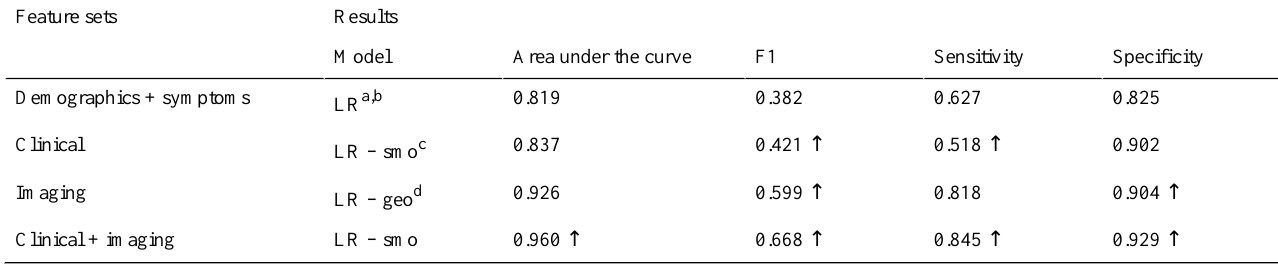
Table 4. The best results obtained using different feature sets after oversampling (arrow indicates improved performance after oversampling). ResultsFeature